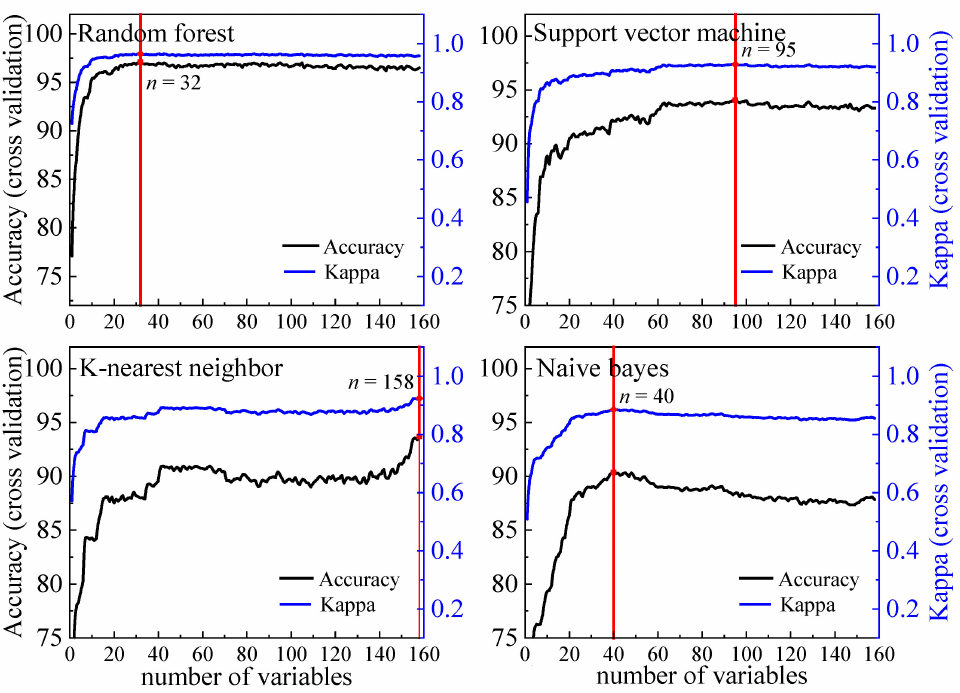
Figure 7. Relationship between the performance of object-based classifiers and the number of variables (feature filtered by RFE). Table 6. Effective features of object-based